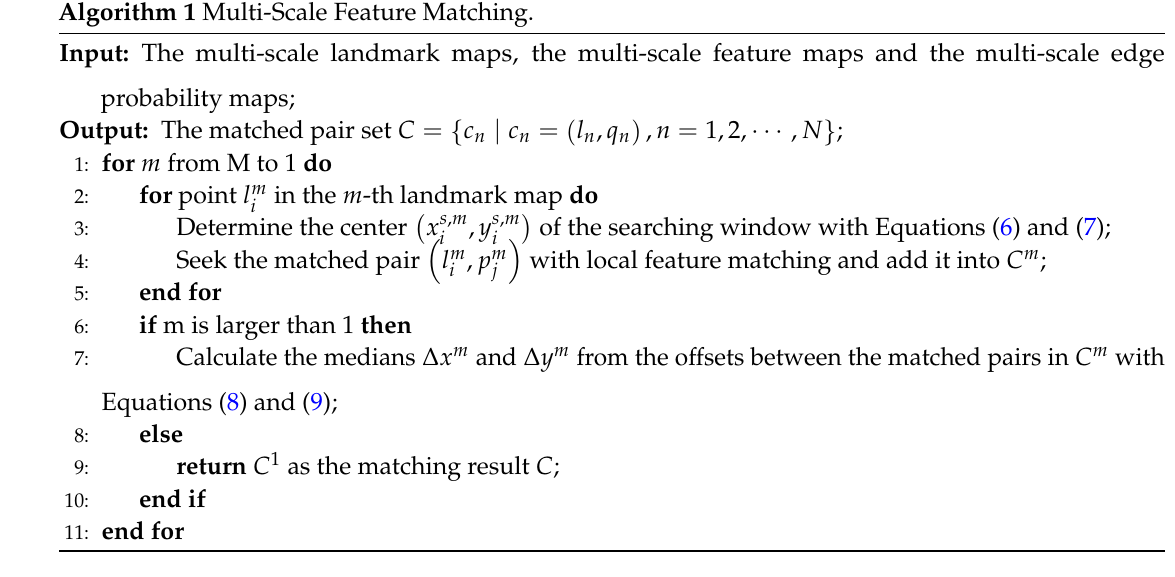
Figure 3. The architecture of multi-scale maps (suppose the sampling frequency f = 2). The subsampling is conducted from bottom to top, and the matching is inverse. The red grid corresponds to the template and the blue grid corresponds to the searching window. The medians ∆ x m + 1 and ∆ y m + 1 calculated in the ( m + 1 ) -th scale are used to determine the center of the searching window in the m -th scale.